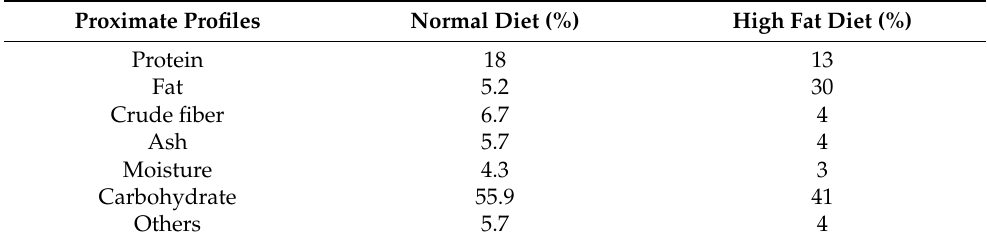
Table 1. Composition of normal and high fat diets. Proximate Profiles Normal Diet